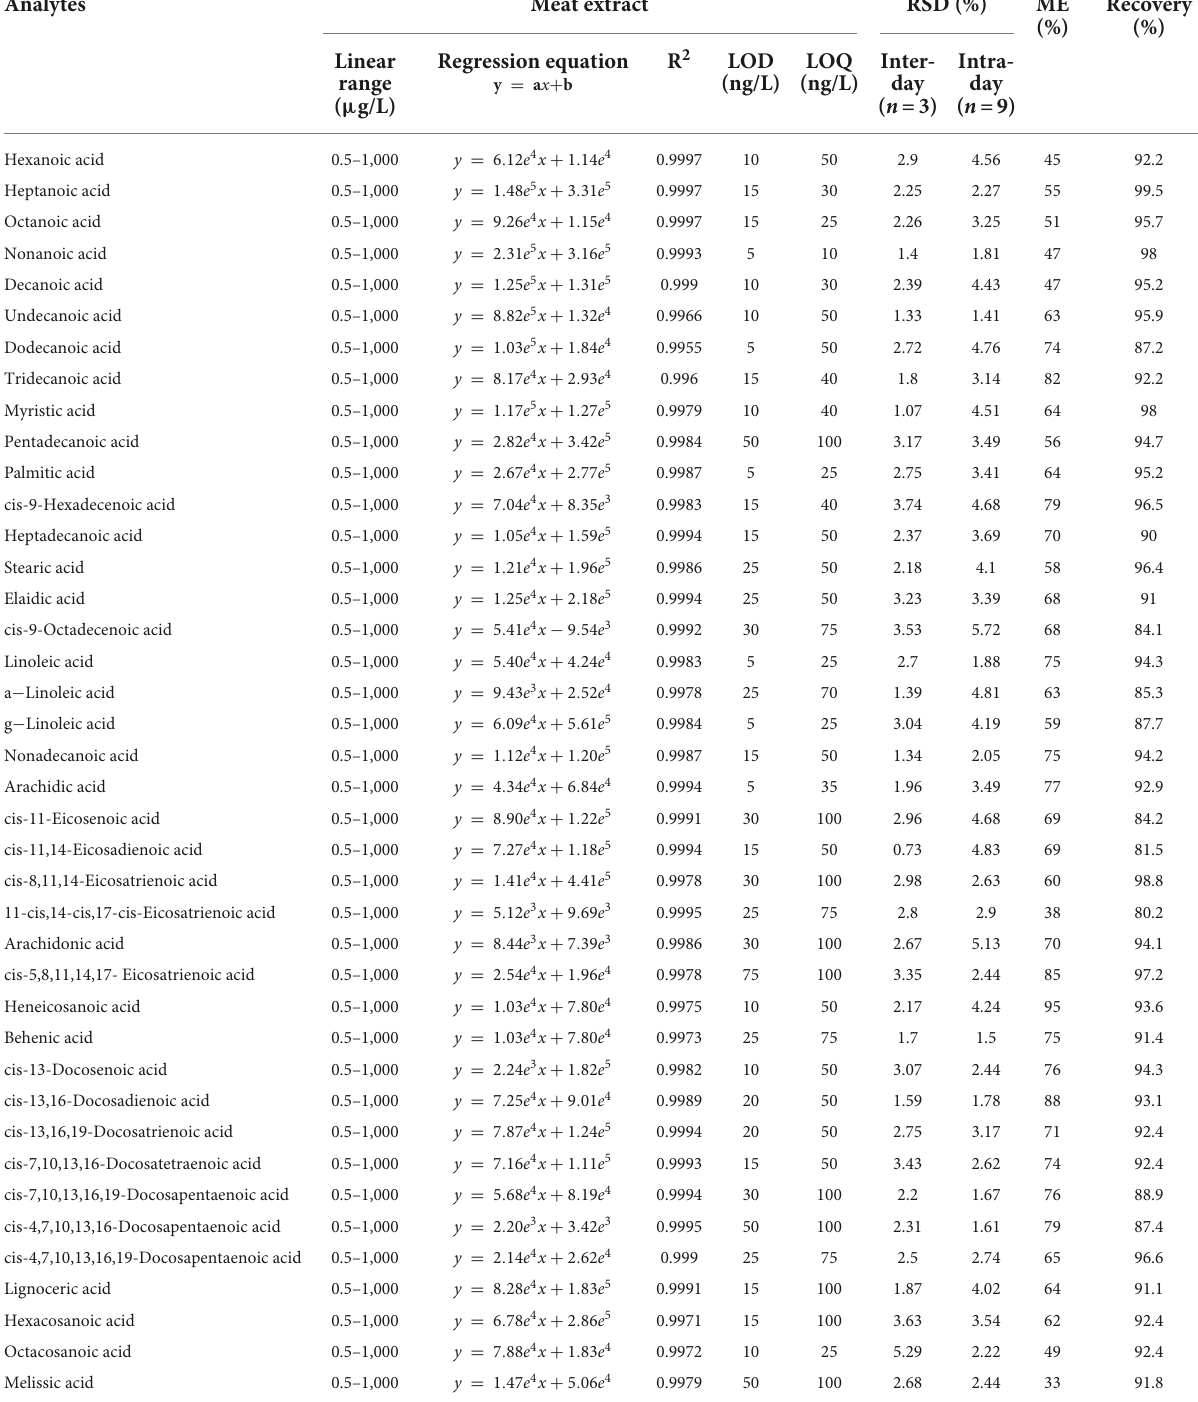
TABLE 1 The linear range, calibration curve, LOD, LOQ, inter- and intra-day assays, matrix effect (ME) and recovery of 5-(dimethyamino)-1-carbohydrazide isoquinoline (DMAQ)-FAs in meat